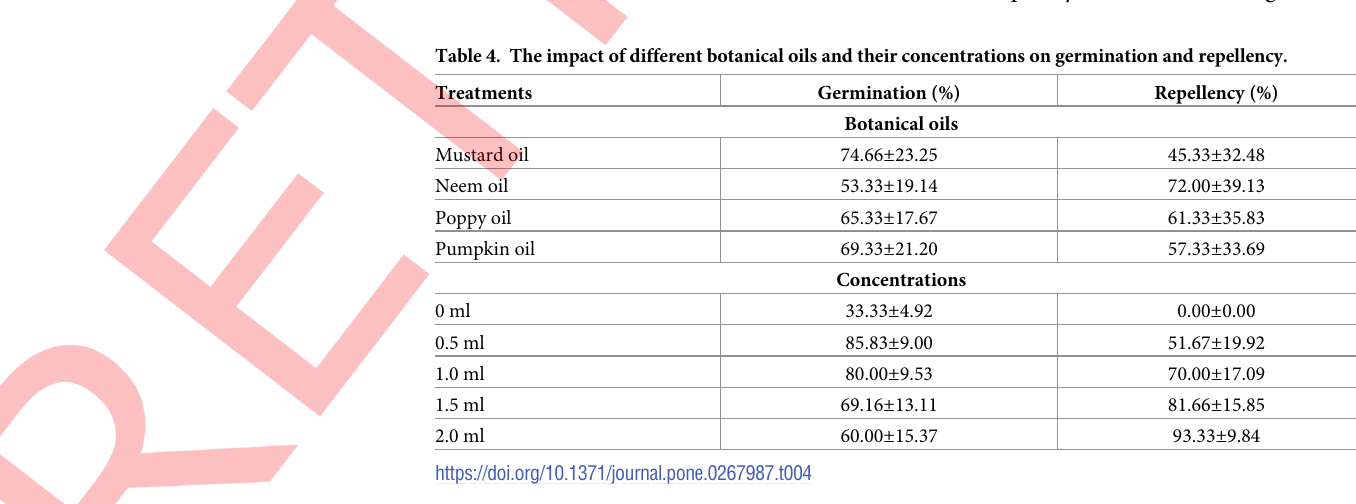
Table 4. The impact of different botanical oils and their concentrations on germination and